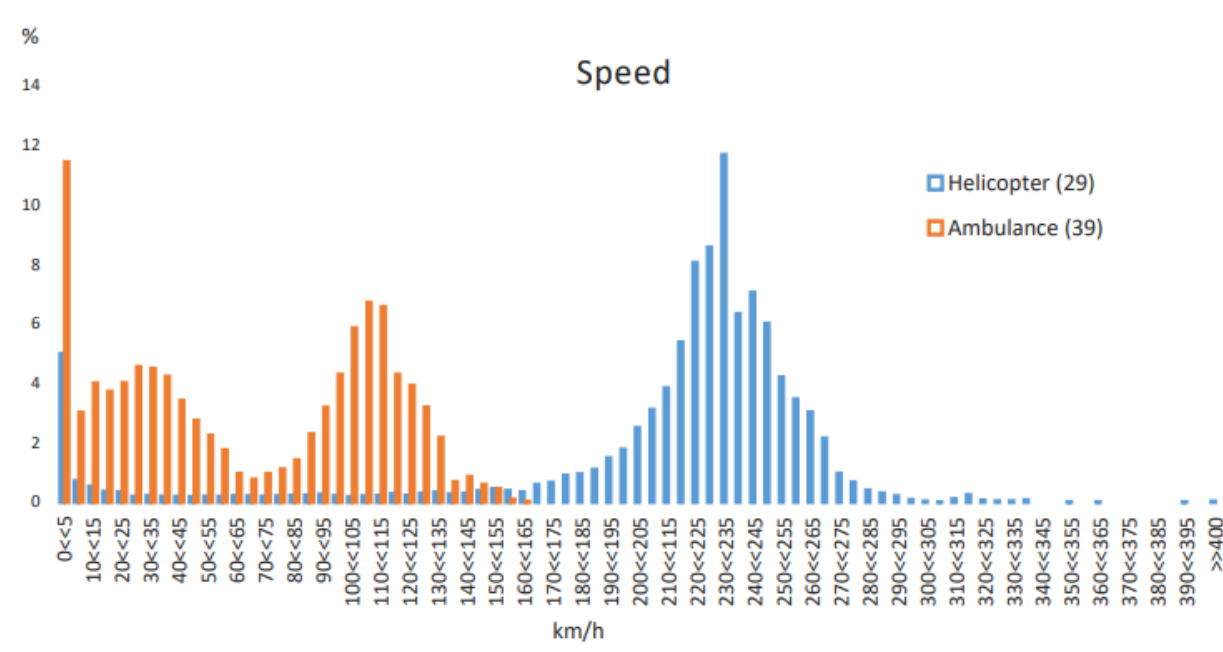
Figure 7 . Speed distribution of ambulance and helicopter . Figure 7. Speed distribution of ambulance and